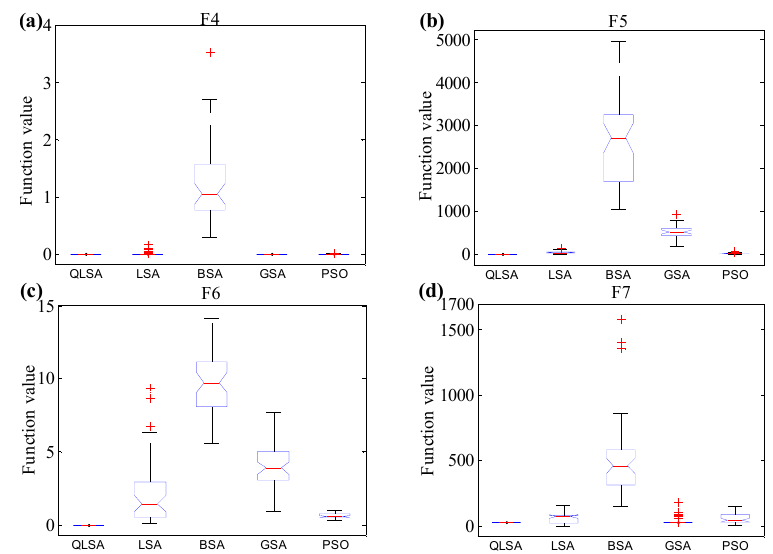
Figure 9. Variation in global optimization results for benchmark functions in Table 4. ( a ) F4; ( b ) F5; ( c ) F6; ( d ) F7.